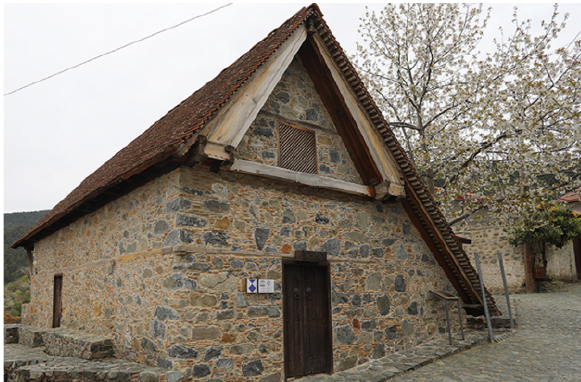
Figure 1. Archangelos Michail, Pedoulas,